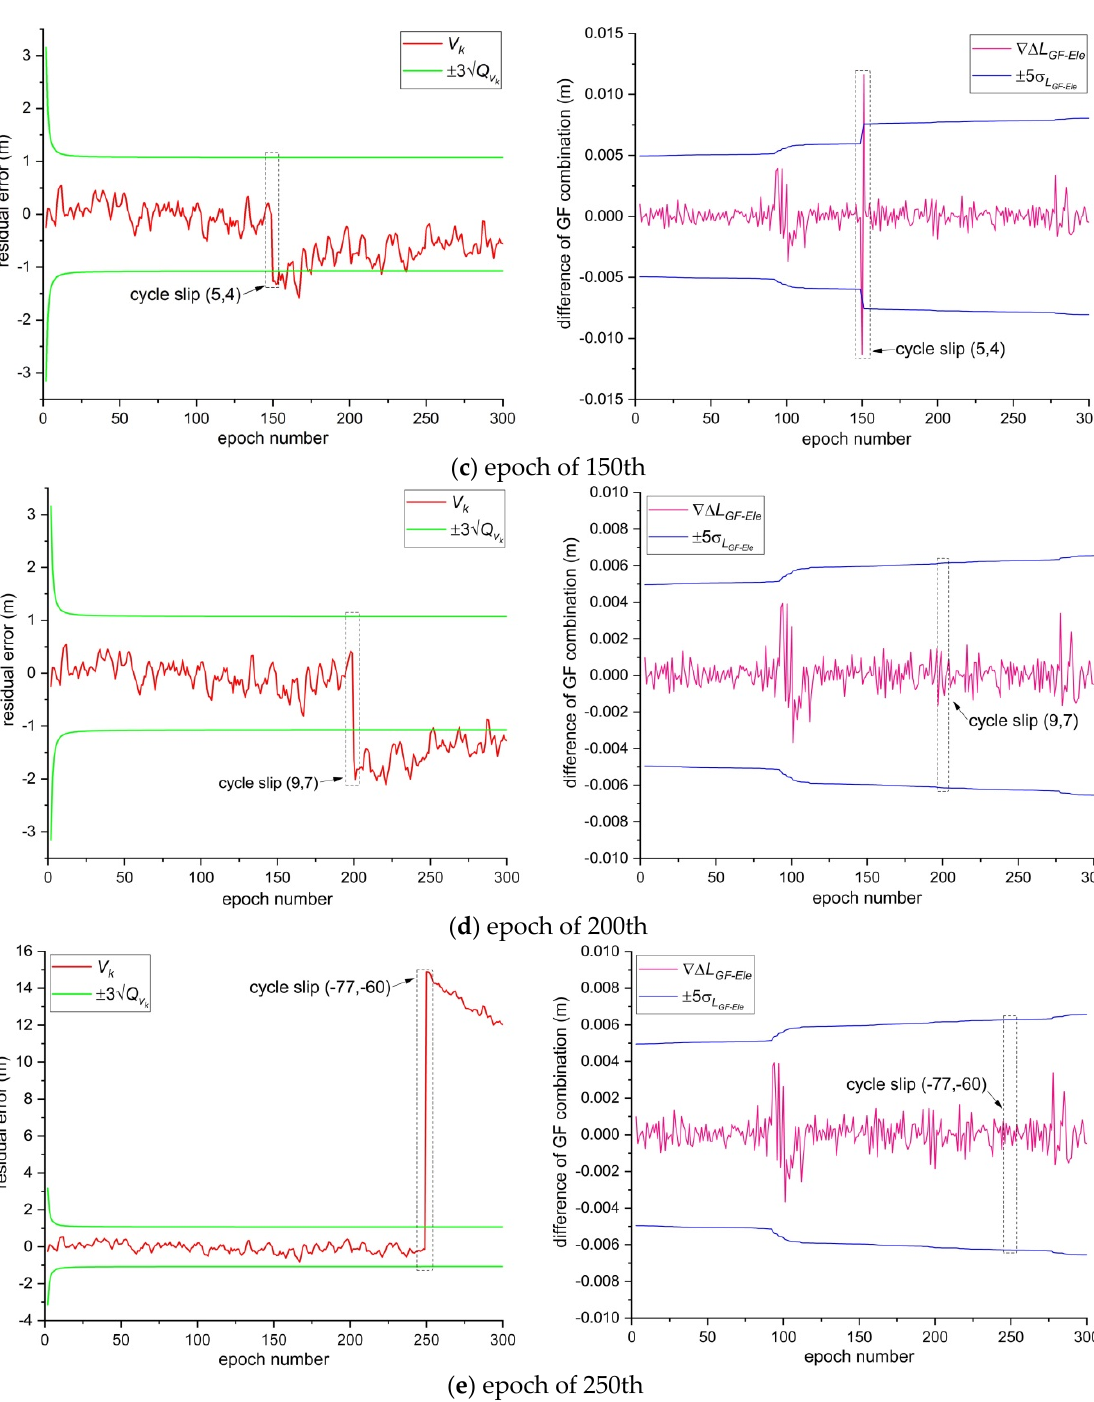
Figure 12. Cycle slip detection results of satellite G26 at different epochs in ionospheric disturbance environment.